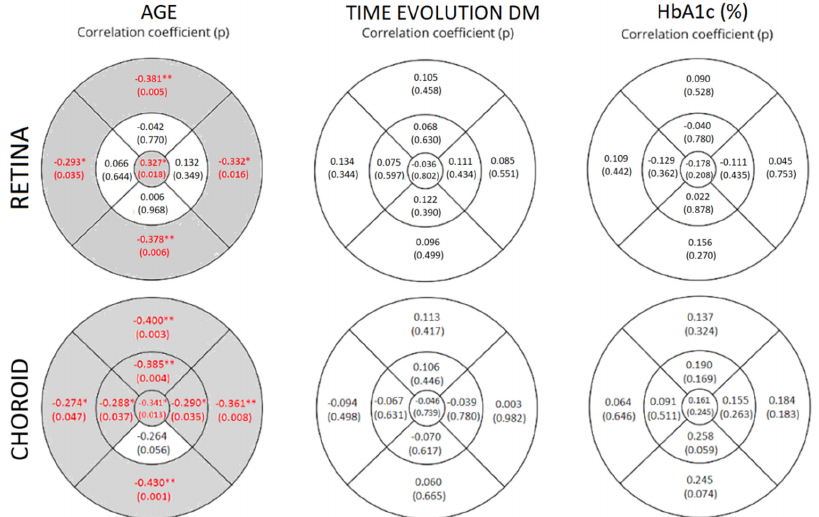
Figure 3. Correlation coefficients and statistical significance ( p -value) of retinal and choroidal thicknesses with age, time of DM evolution, and glycosylated hemoglobin (HbA1c) levels (%) in DM2 patients. They are represented in the nine areas of the early treatment diabetic retinopathy study (ETDRS) grid. The left areas represent the temporal quadrants, and the right areas represent the nasal quadrants, as if a right eye was represented. The values that reached statistical significance ( p < 0.05) are shown in red with a grey background and marked with (*) when p < 0.05 and with (**) when p < 0.01.